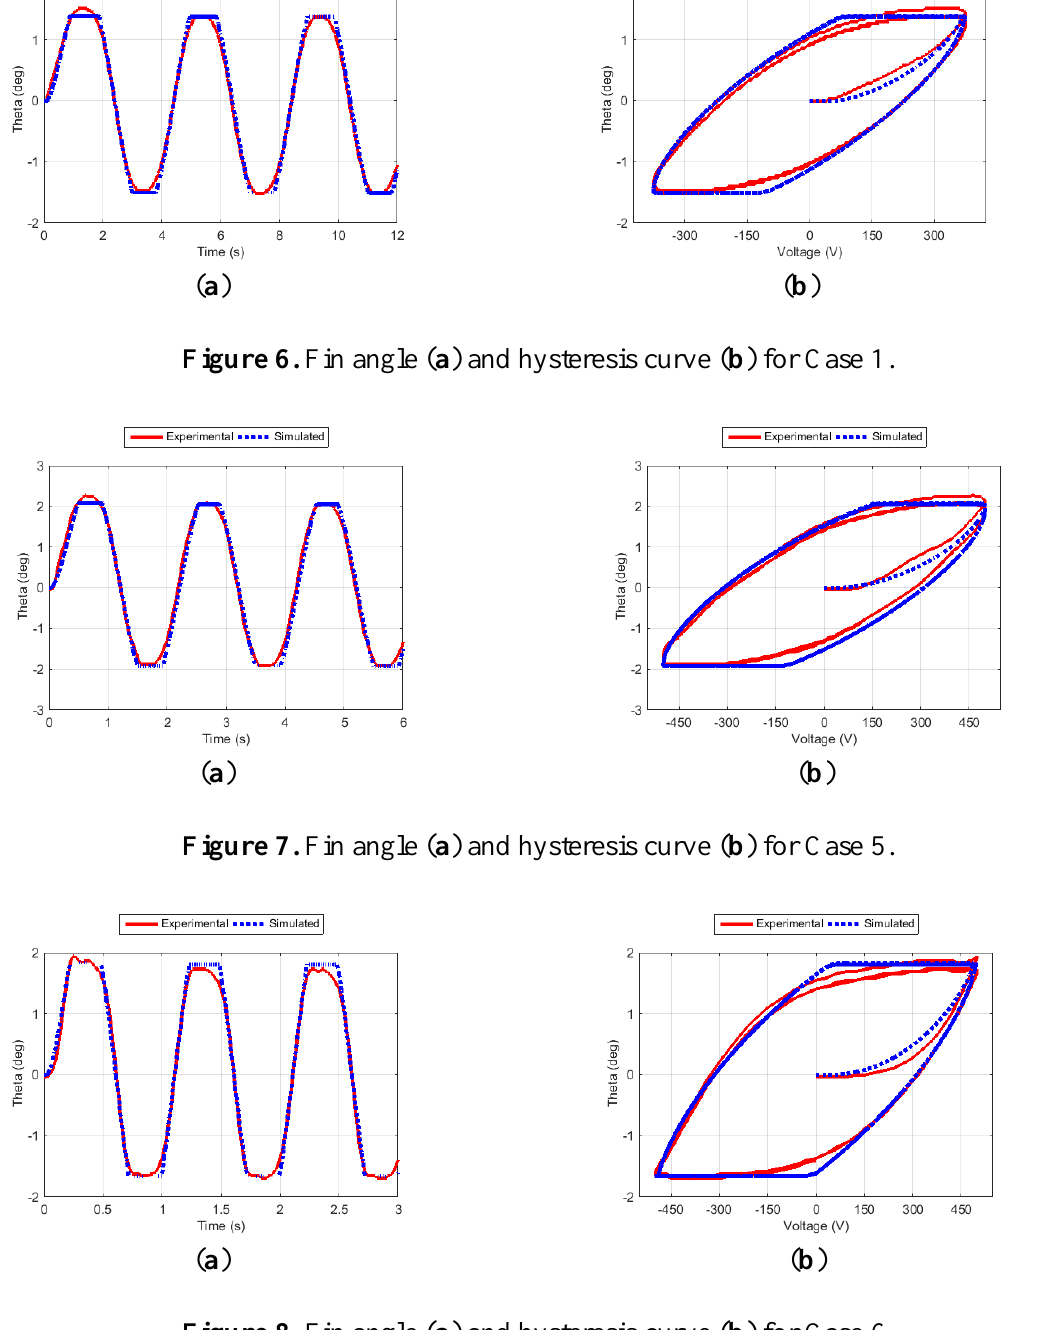
Figure 8. Fin angle ( a ) and hysteresis curve ( b ) for Case